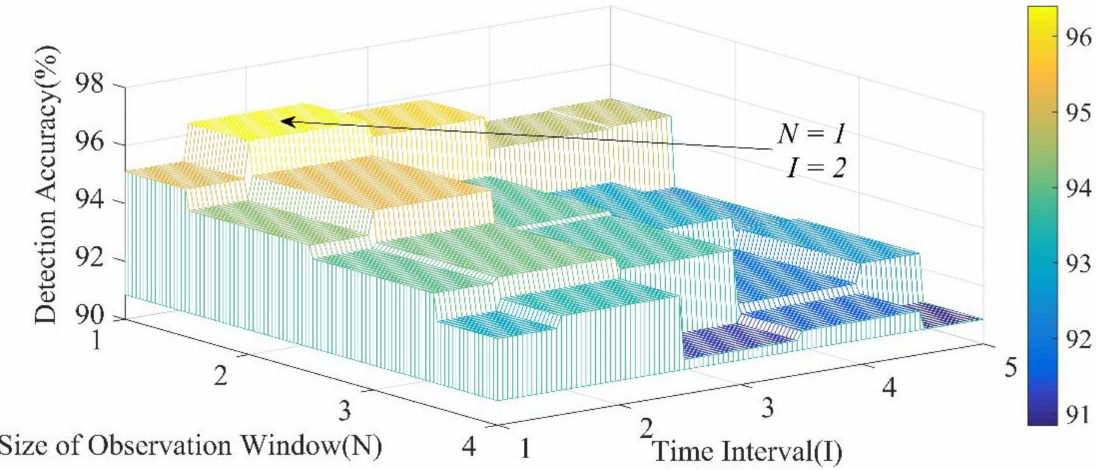
Figure 8. Accuracy of different N and I .